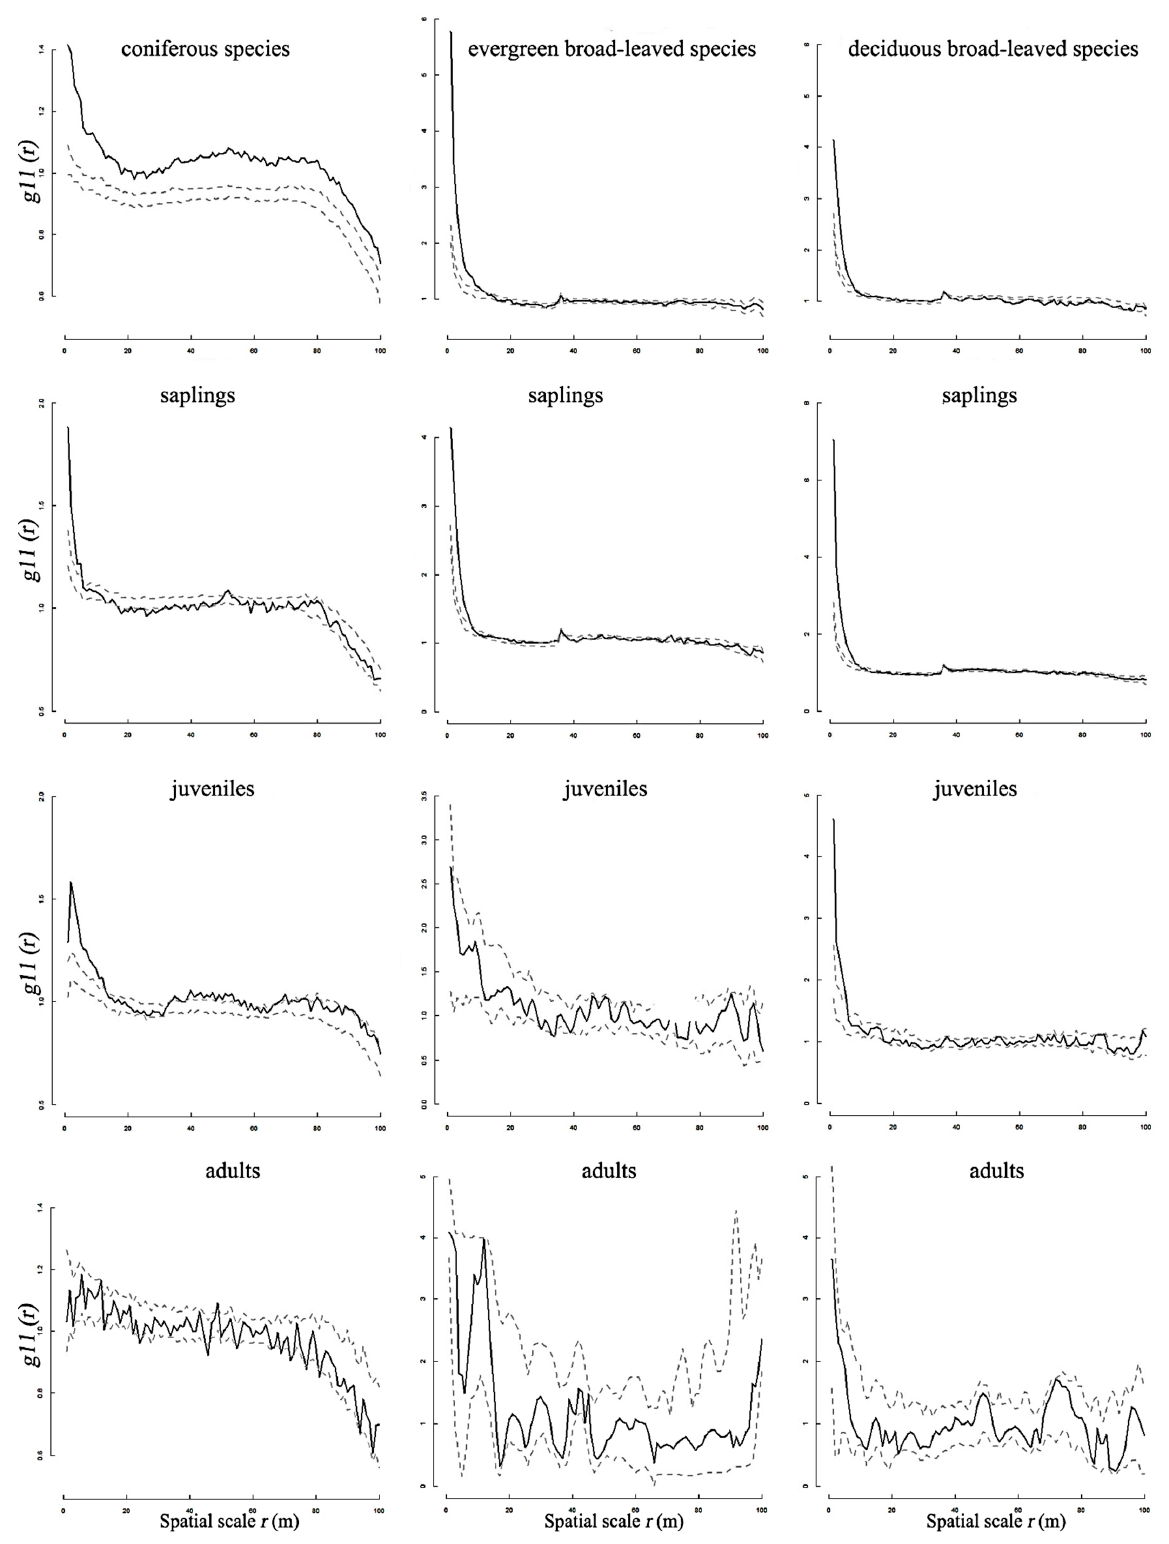
Figure 2. Spatial patterns of broad-leaved (deciduous or evergreen) and coniferous species in the mixed forest community. The dotted lines 99% confidence interval and the black lines represent the g11(r) function. Observed values below the lower limits represent a regular/hyper dispersed pattern, values above the upper limits are a clumped distribution, and values within the intervals are due to random spatial